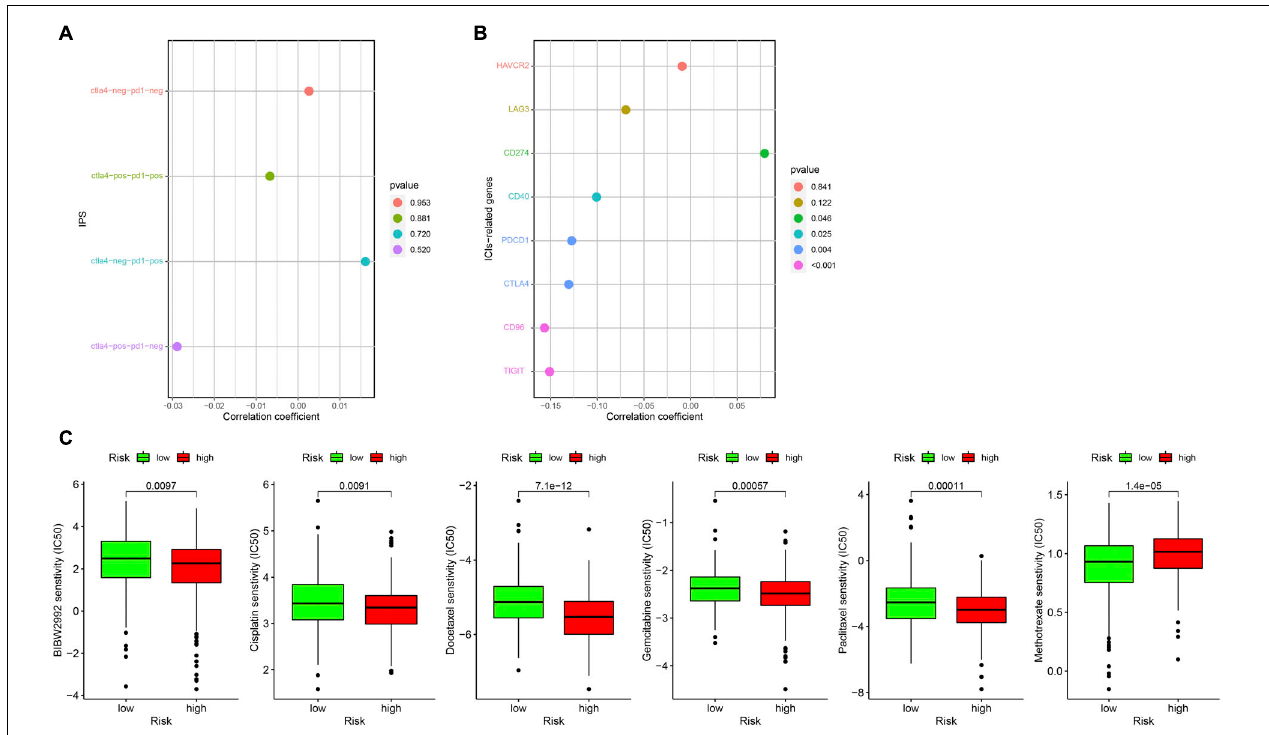
FIGURE 10 | Correlation between prognostic model and clinical treatment. (A) The correlation point graph shows the correlation between four types of IPS and risk score. (B) The lollipop graph shows the correlation between eight ICIs-related genes and risk score. (C) The box diagram shows the difference in IC50 of the six chemotherapy in the high- and low-risk